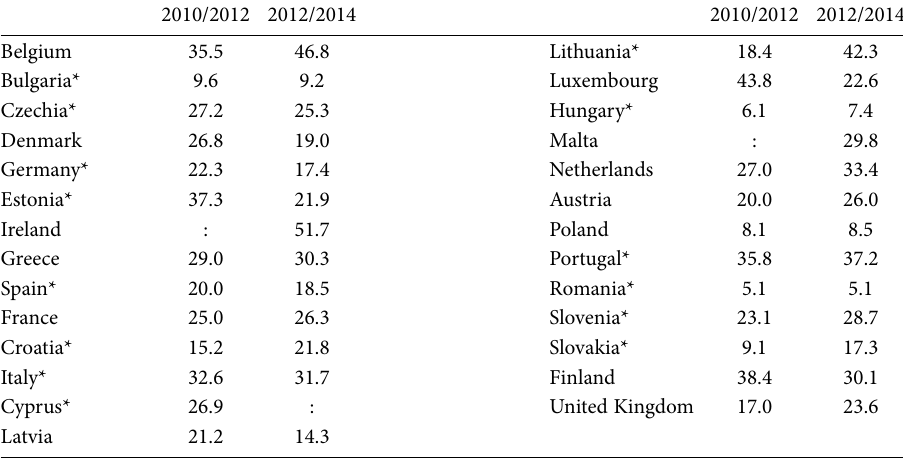
Table 1. Enterprises in the food processing industry that have introduced process